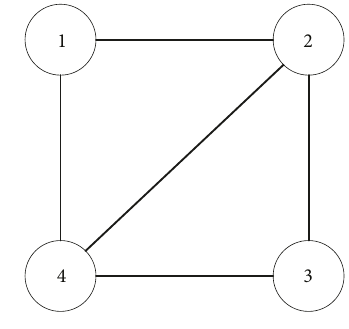
Figure 1: The undirected network